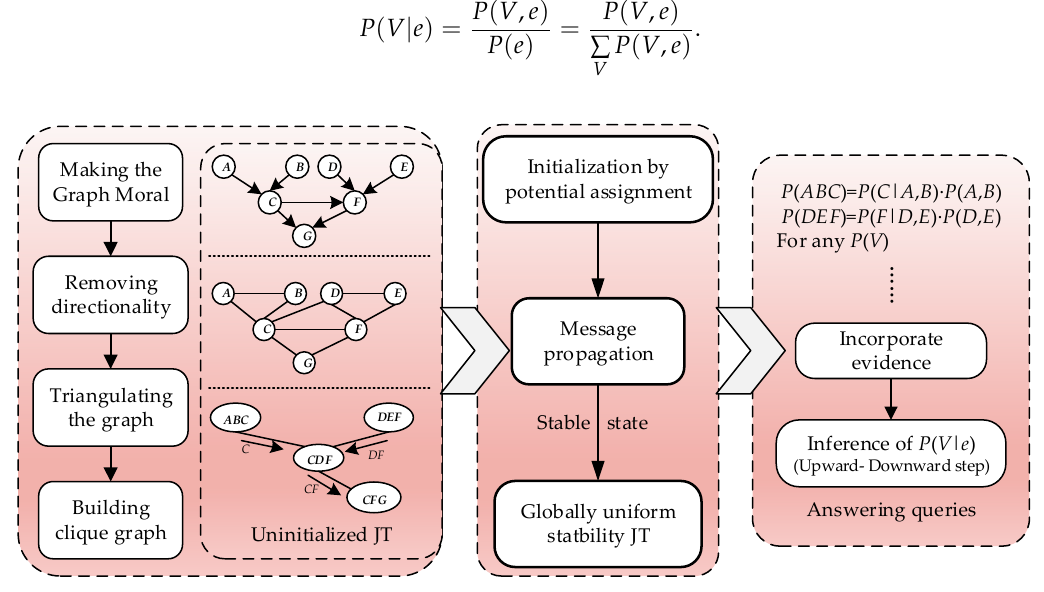
Figure 2. Algorithm and build thought of JT.